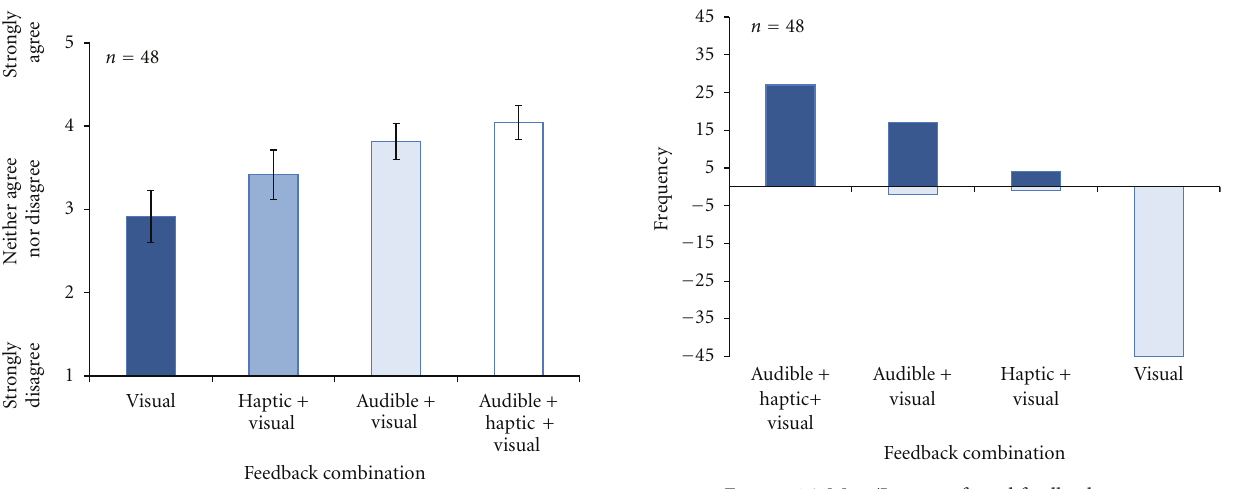
Figure 16: Most/Least preferred feedback